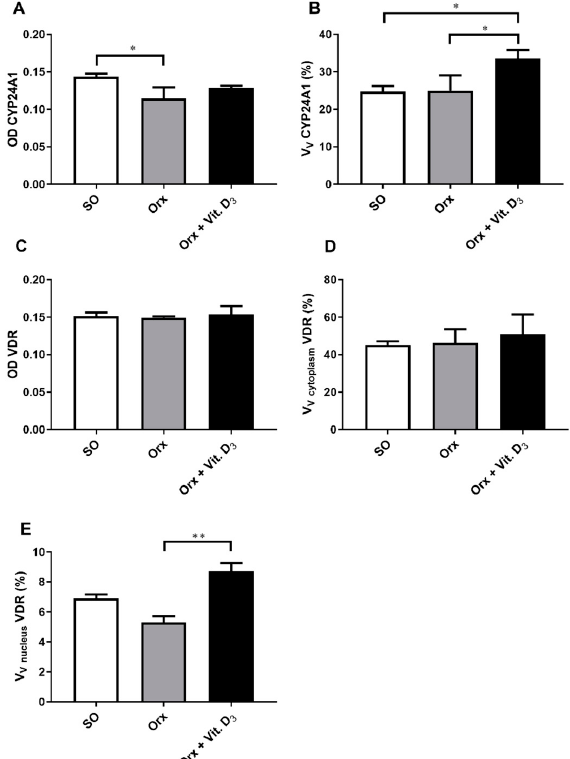
Figure 6. Optical density (OD) of CYP24A1 immunopositivity ( A ), the relative volume density of CYP2R1-immunopositive cells (Vv CYP2R1; %; ( B )), the optical density (OD) of VDR immunopositivity ( C ), the relative volume density of vitamin D receptor in the cell cytoplasm (Vv cytoplasm VDR; %; ( D )) and nucleus (V V nucleus VDR; %; ( E )) in the thyroid of sham-operated (SO), orchidectomized (Orx) and orchidectomized cholecalciferol-treated (Orx + Vit. D 3 ) rats. All values are means ± SD ( n = 6); *, p < 0.05; **, p < 0.01.